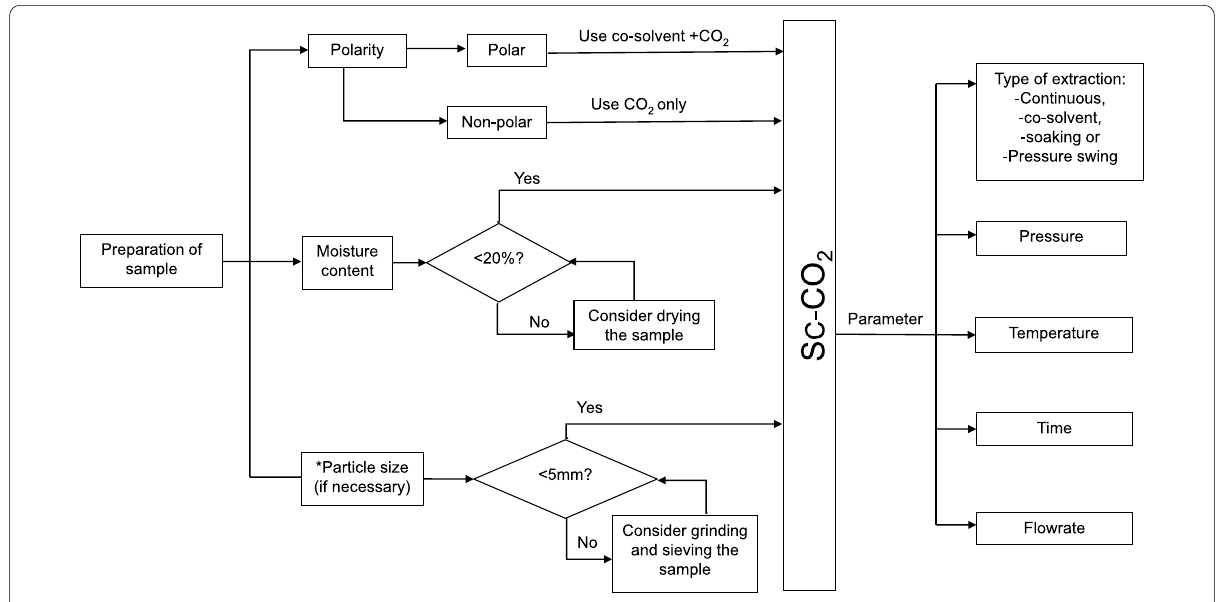
Fig. 3 A process flow diagram for the sample preparation of FBP prior to Sc-CO